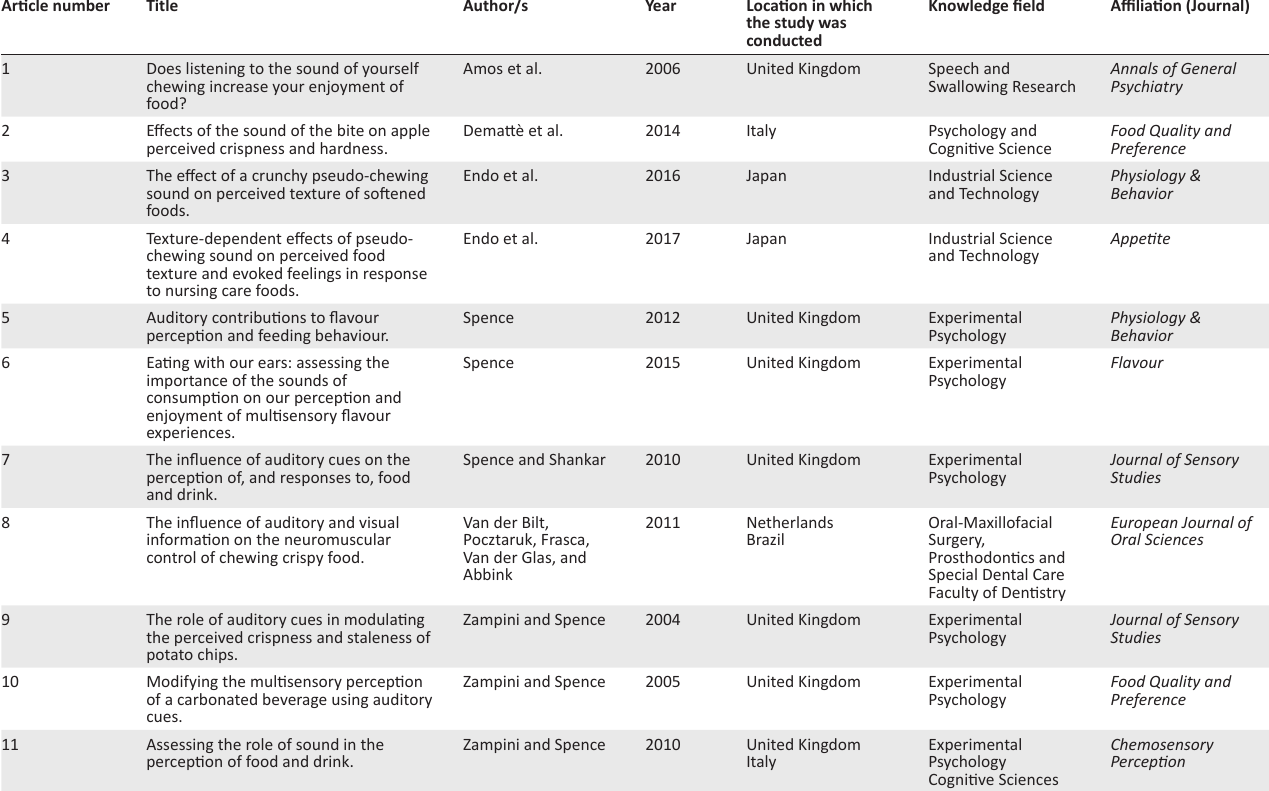
TABLE 1-A4: Bibliographic data of the 11 included